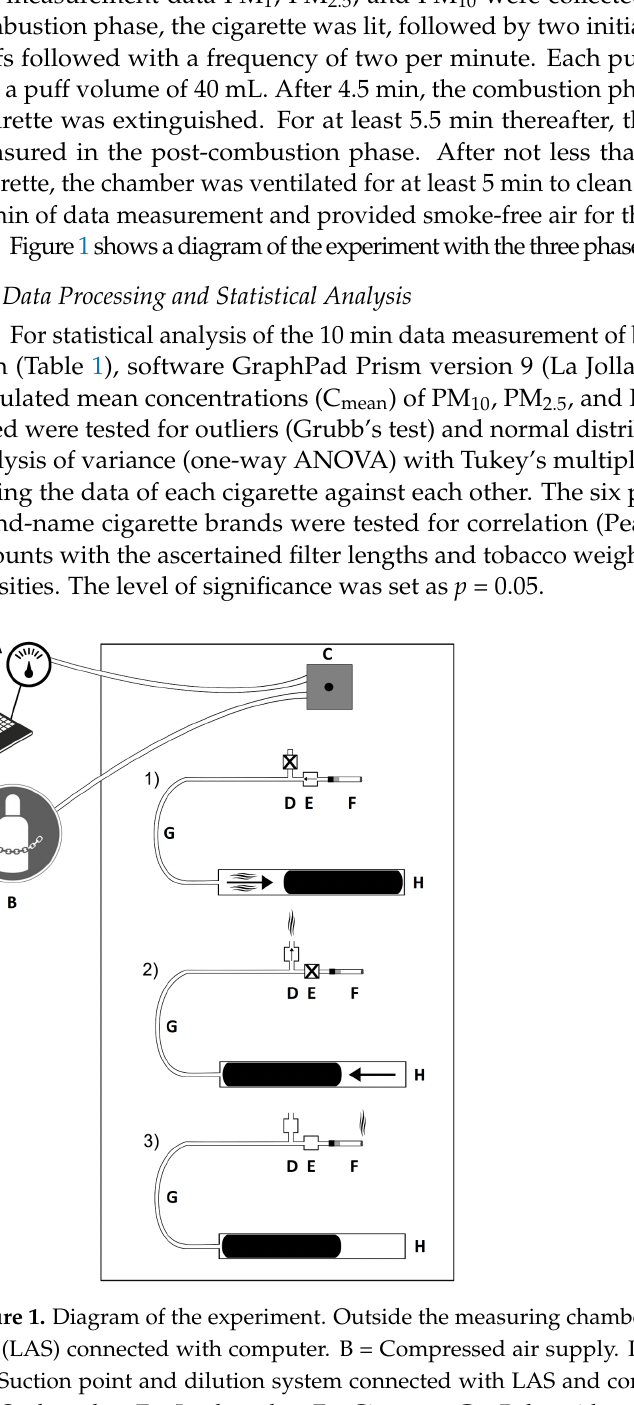
Figure1showsadiagramoftheexperimentwiththethreephasesoftobaccoproduct smoking.